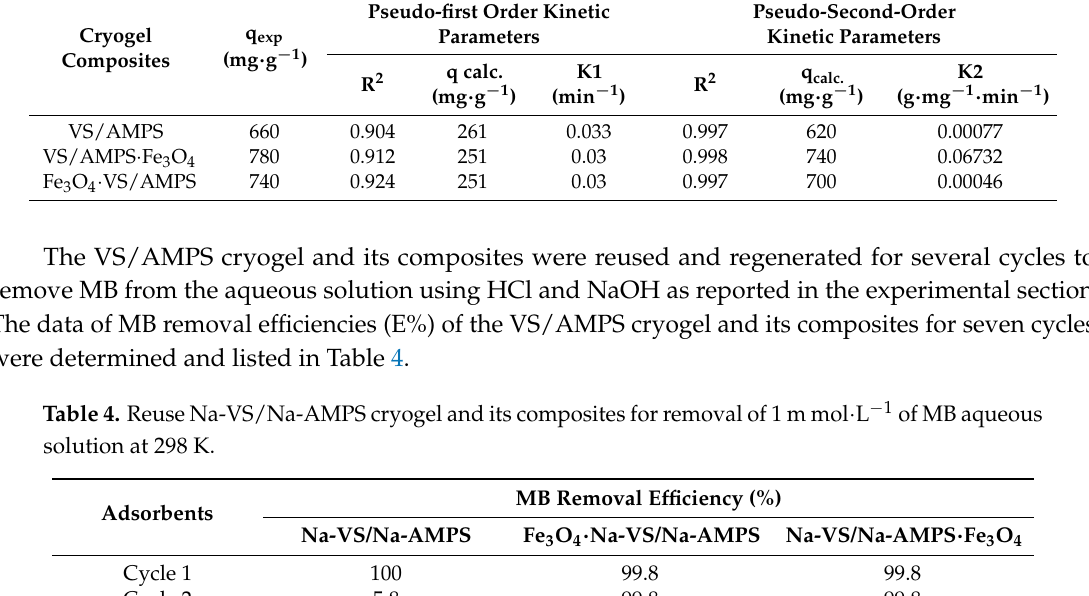
Table 3. Kinetic parameters of VS/AMPS cryogel and its composites for removal of MB from an aqueous solution at temperature 298 K.